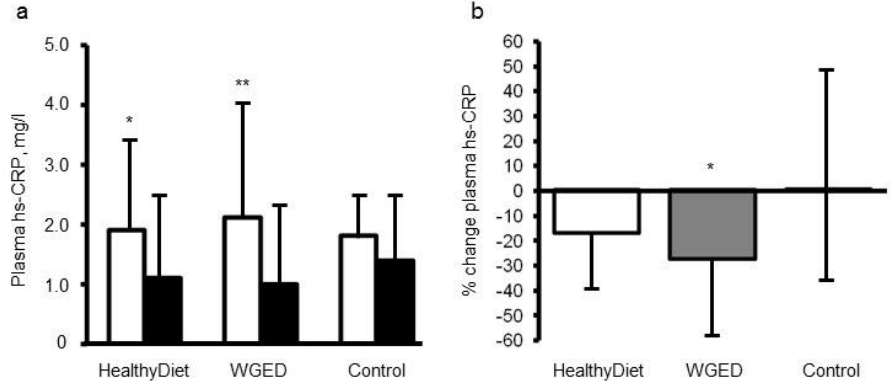
Figure 2. Plasma concentrations ( a ) and relative changes ( b ) of high sensitivity C-reactive protein (hsCRP) according to study group in the participants not using statins during the SYSDIMET intervention [29]. ( a ) White bars represent hsCRP concentrations at baseline and black bars after a 12 week consumption of HND ( n = 27), Whole Grain Enriched Diet (WGED) ( n = 24) or control diet ( n = 25).* p < 0.05 and ** p < 0.001 for baseline vs. week 12 in Student’s paired test. ( b ) p = 0.04 for the group effect in general linear model univariate analysis. * p < 0.05 for the difference between WGED and control groups after Bonferroni correction for multiple comparisons. Values are median and interquartile range (IQR).